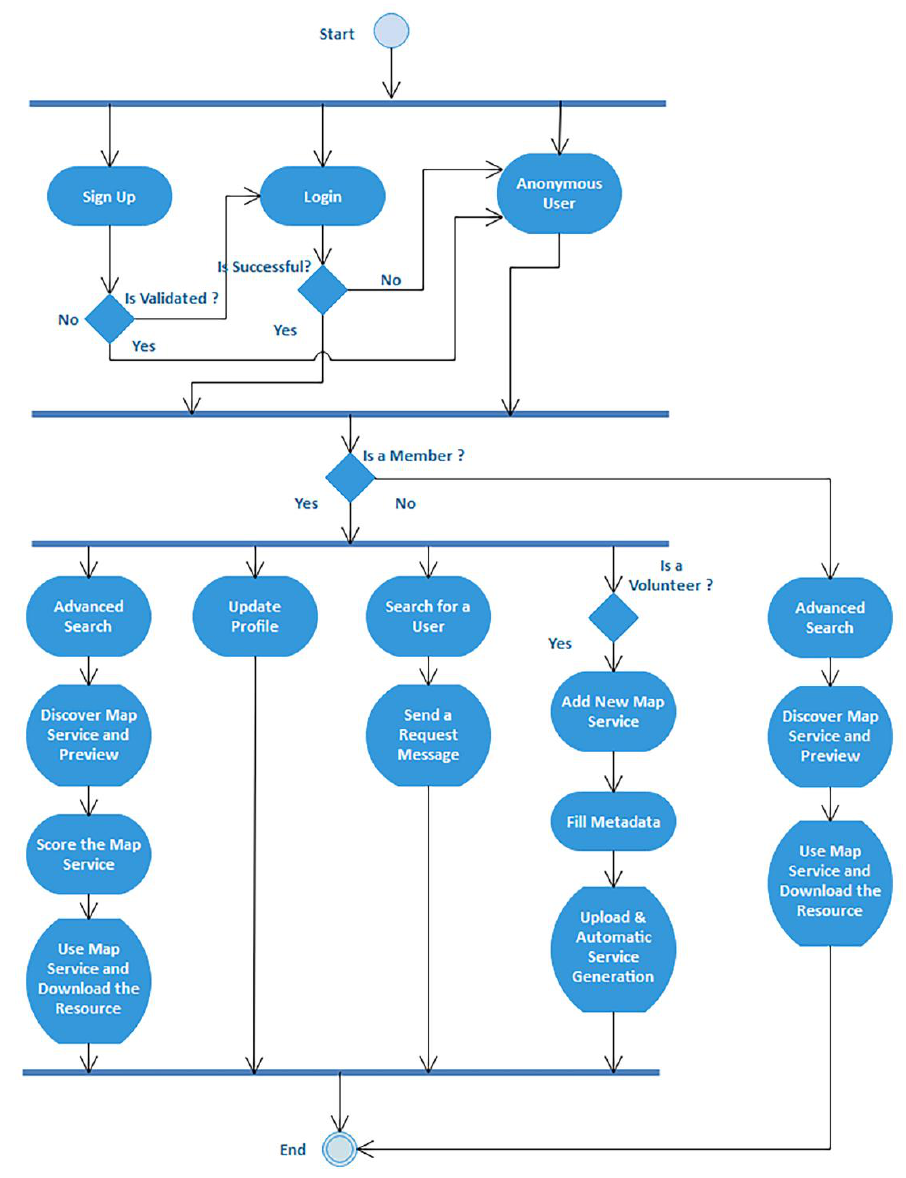
Figure 6. Activity diagram of the main decision paths that various types of users may